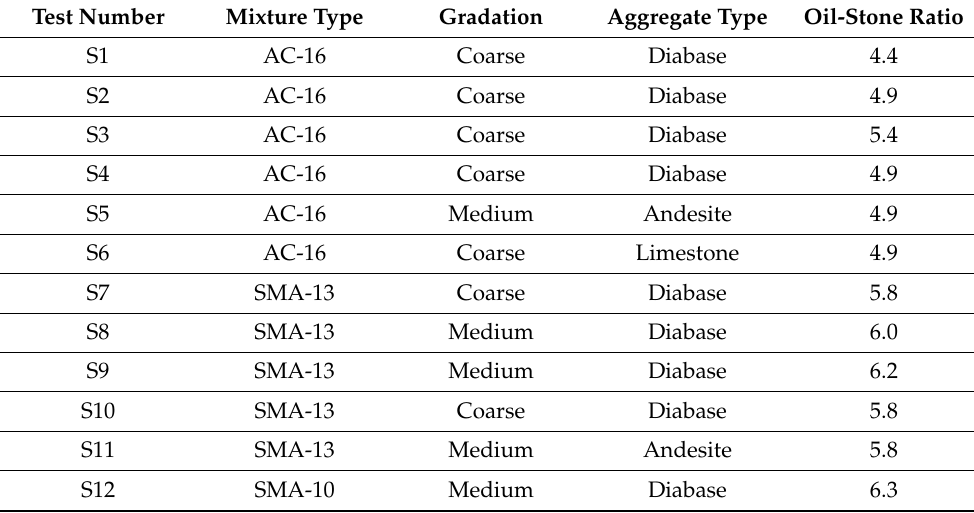
Table 1. Experiment plan.